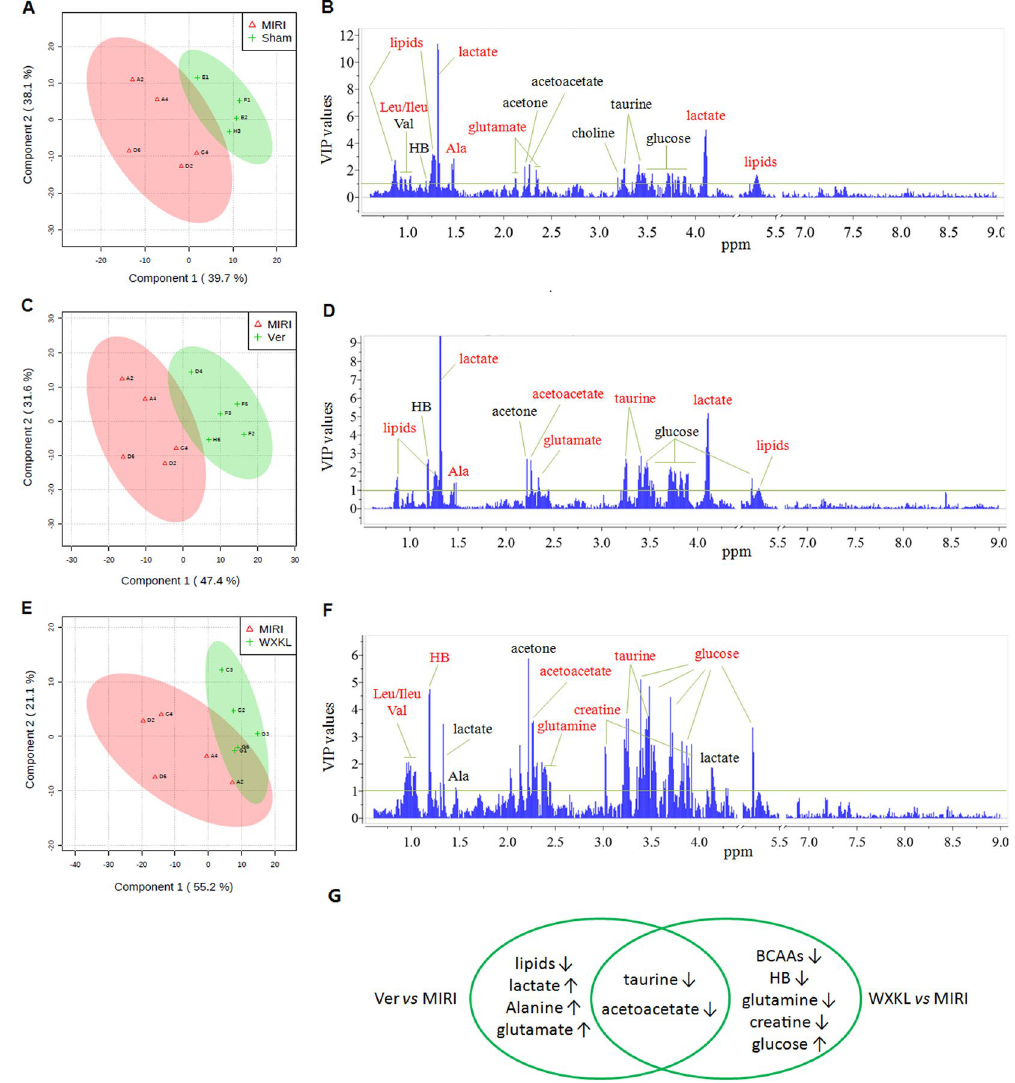
Figure 4. The score plots and VIP plots between ( A , B ) sham and MIRI groups, ( C , D ) MIRI and Ver groups, ( E , F ) MIRI and WXKL groups. ( G ) A summary of the differential metabolites extracted in the three comparison